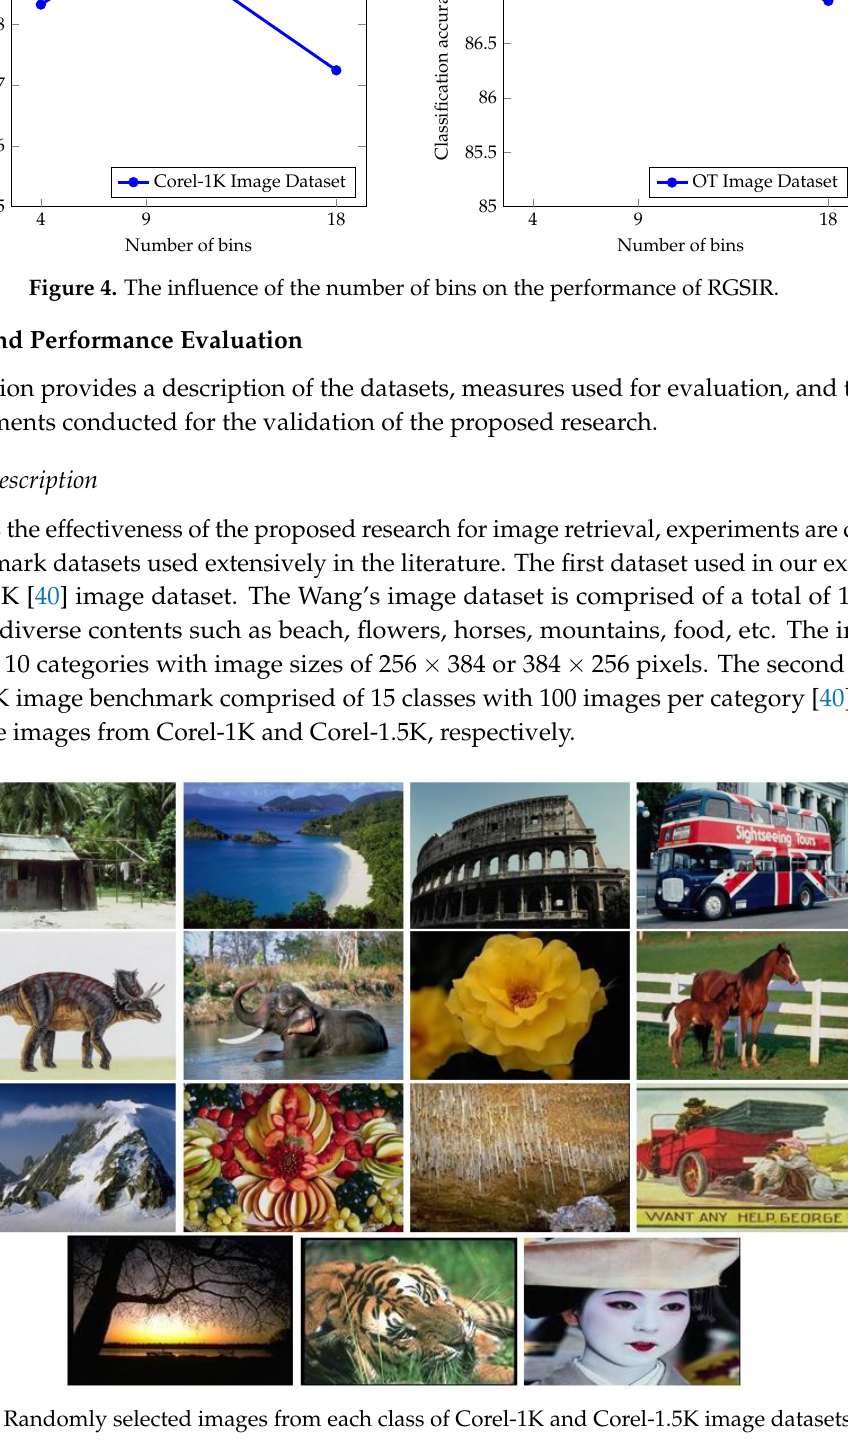
20 semantic categories. Example images from this dataset are shown in Figure